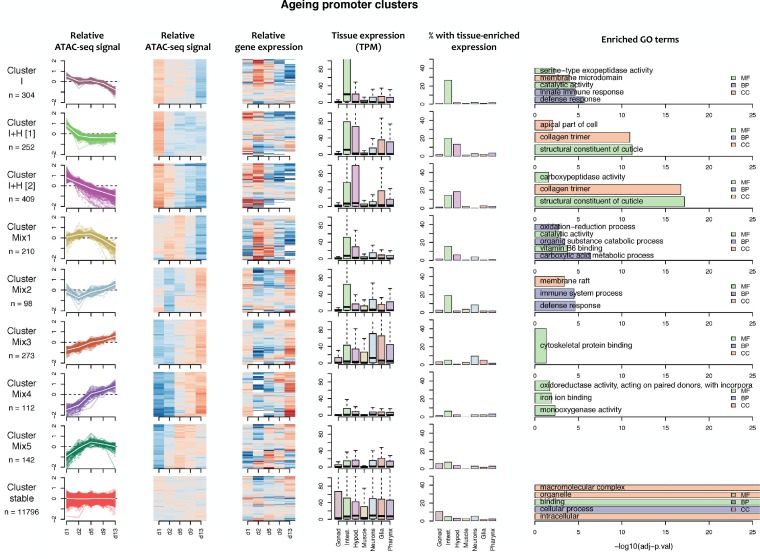
Characteristics of ageing promoter clusters.Characteristics of promoter clusters with shared accessibility patterns across ageing. Relative promoter ATAC-seq coverage is shown across the time series as a graph (each line representing a promoter) and a heatmap (each row representing a promoter). Values are scaled from −2 (dark blue) to 0 (white) to +2 (dark red). Heatmap showing relative expression of the associated genes across the time series, using the same color scale. Tissue expression box plots show TPMs of clustered genes in individual tissues (data from Cao et al., 2017). Percentage of genes with tissue-enriched expression shows the percentage of genes within the cluster with enriched expression in the indicated tissues. Enriched GO terms show the top five enriched GO terms obtained for each cluster from the corresponding list of genes using gProfiler. MF = Molecular Function, CC = Cellular Component, BP = Biological Process. Note that Cluster Mix5 does not have any enriched GO terms.